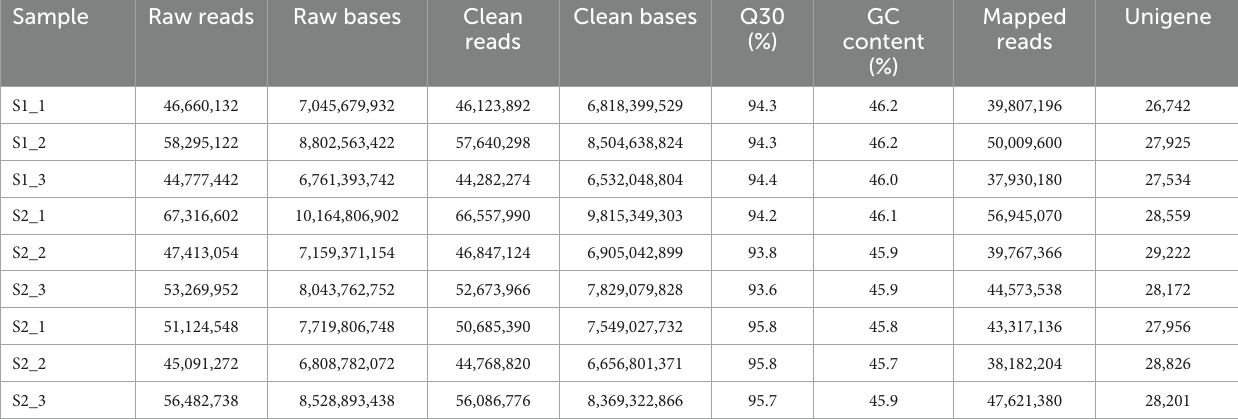
TABLE 2 Summary statistics of RNA-seq results in chayote fruits at three different storage